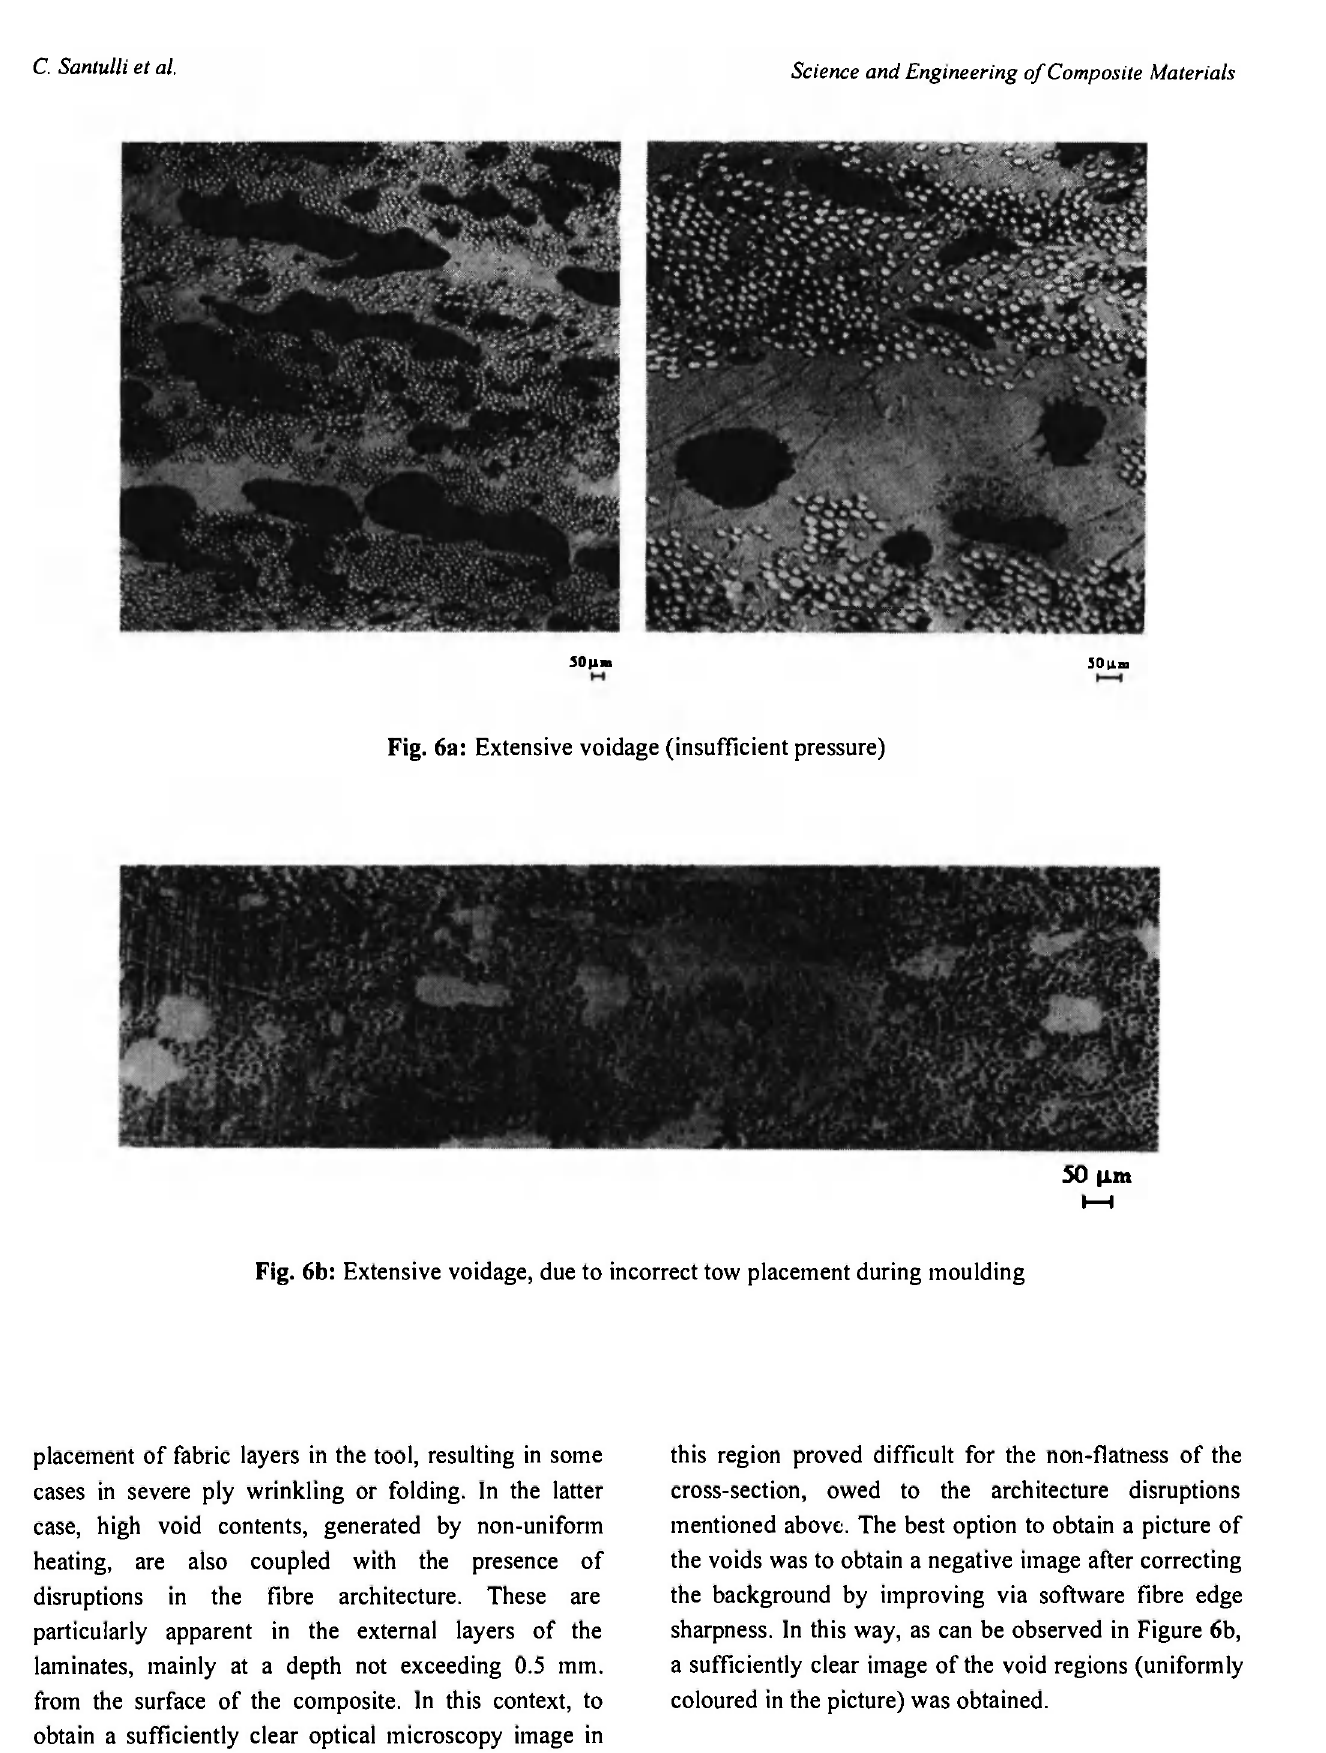
Fig. 6a: Extensive voidage (insufficient pressure)